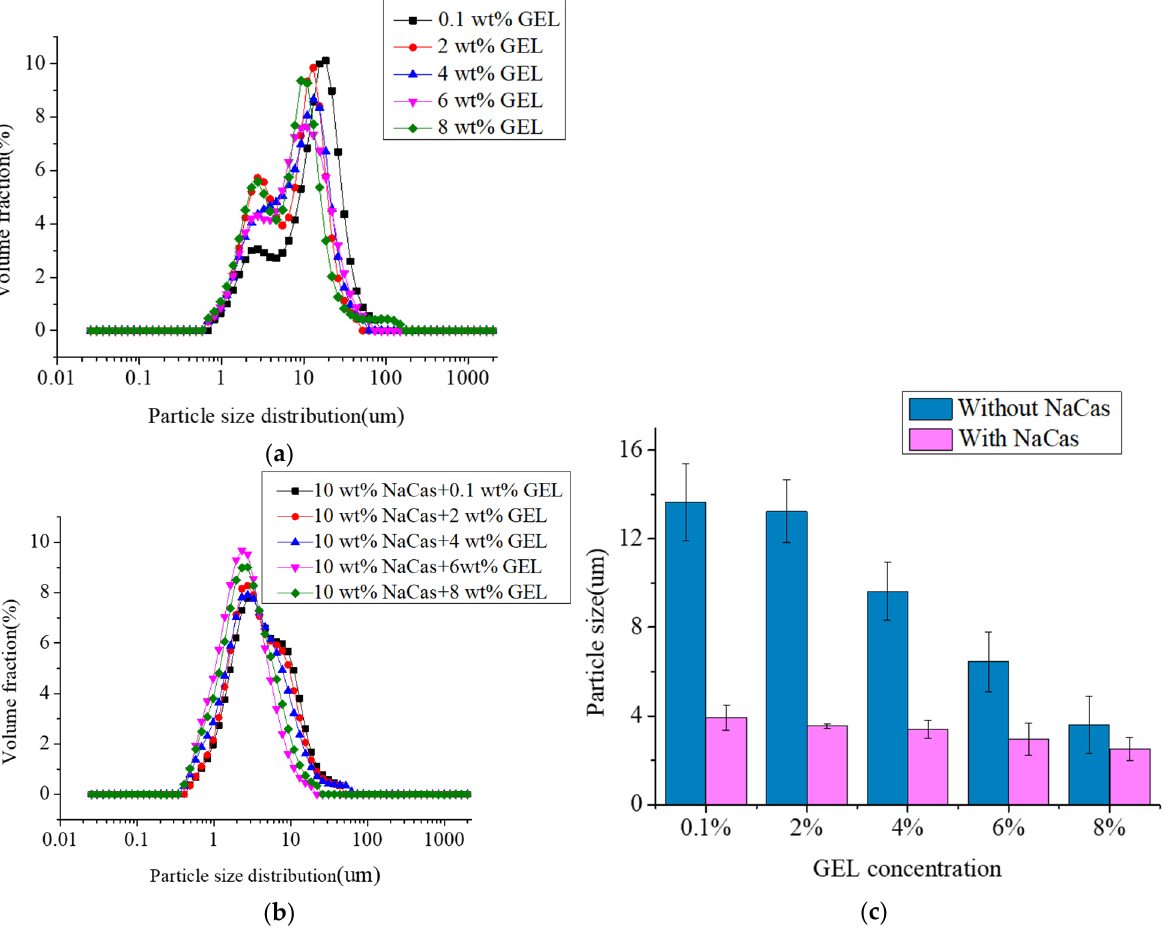
Figure 2. Particle size analysis of CaCO 3 S/O/W emulsions prepared by different GEL concentrations (0.1, 2, 4, 6, 8 wt%). Particle size distribution—( a ) without NaCas; ( b ) with NaCas; ( c ) mean particle size.